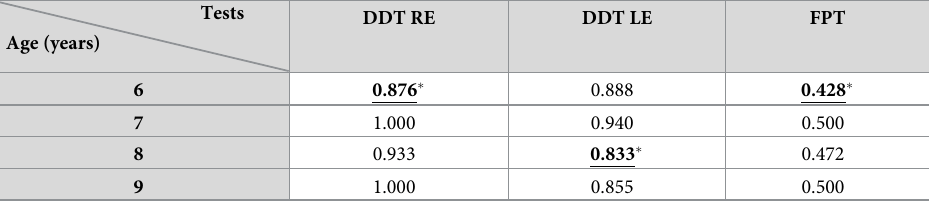
Table 11. Comparison of percentage medians of standard APD results, in all age groups, in group”S”.